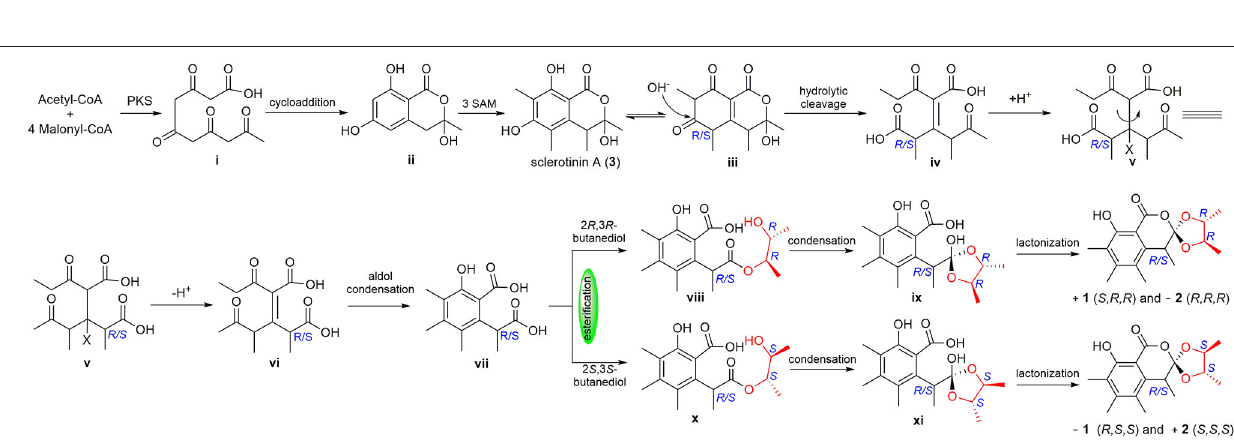
FIGURE 6 | Proposed biosynthetic pathway of 1 and 2